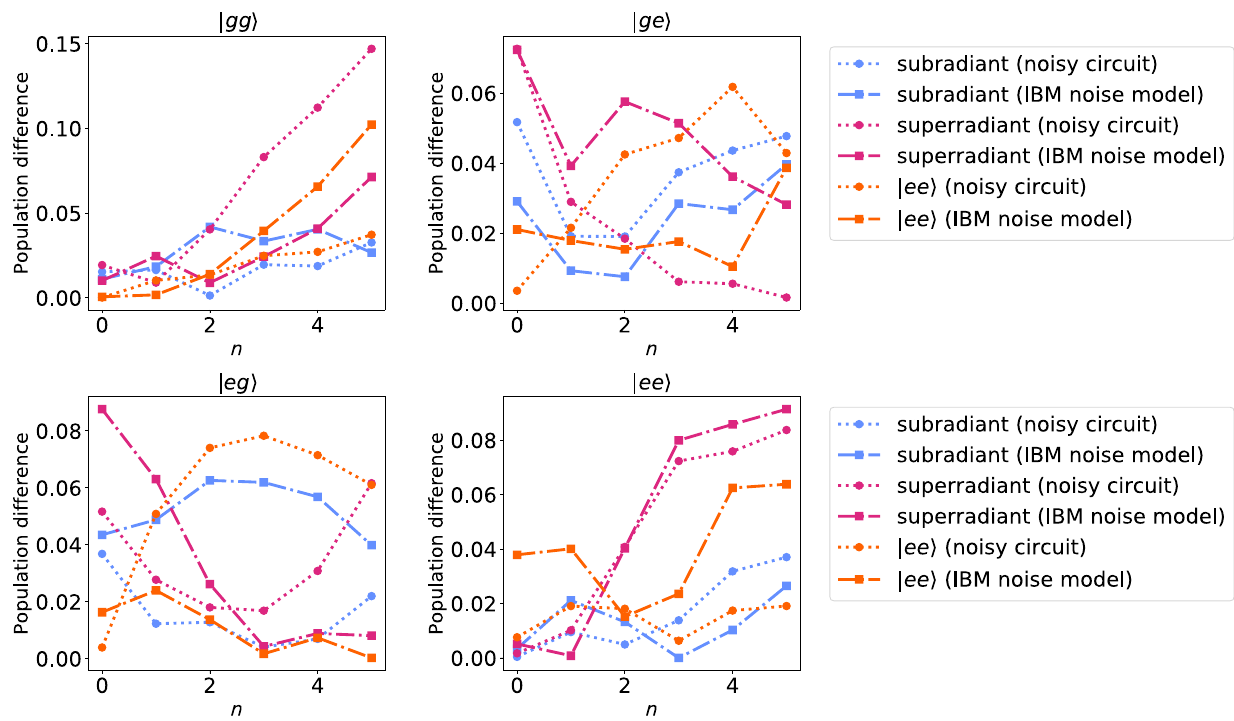
FIG. 5. The absolute value of the population difference between the experimental state and the state simulated through the IBM noise model (the square markers on the dash-dotted lines) and between the experimental state and the state simulated on the noisy circuit (the circular markers on the dotted lines) as a function of the MCM time